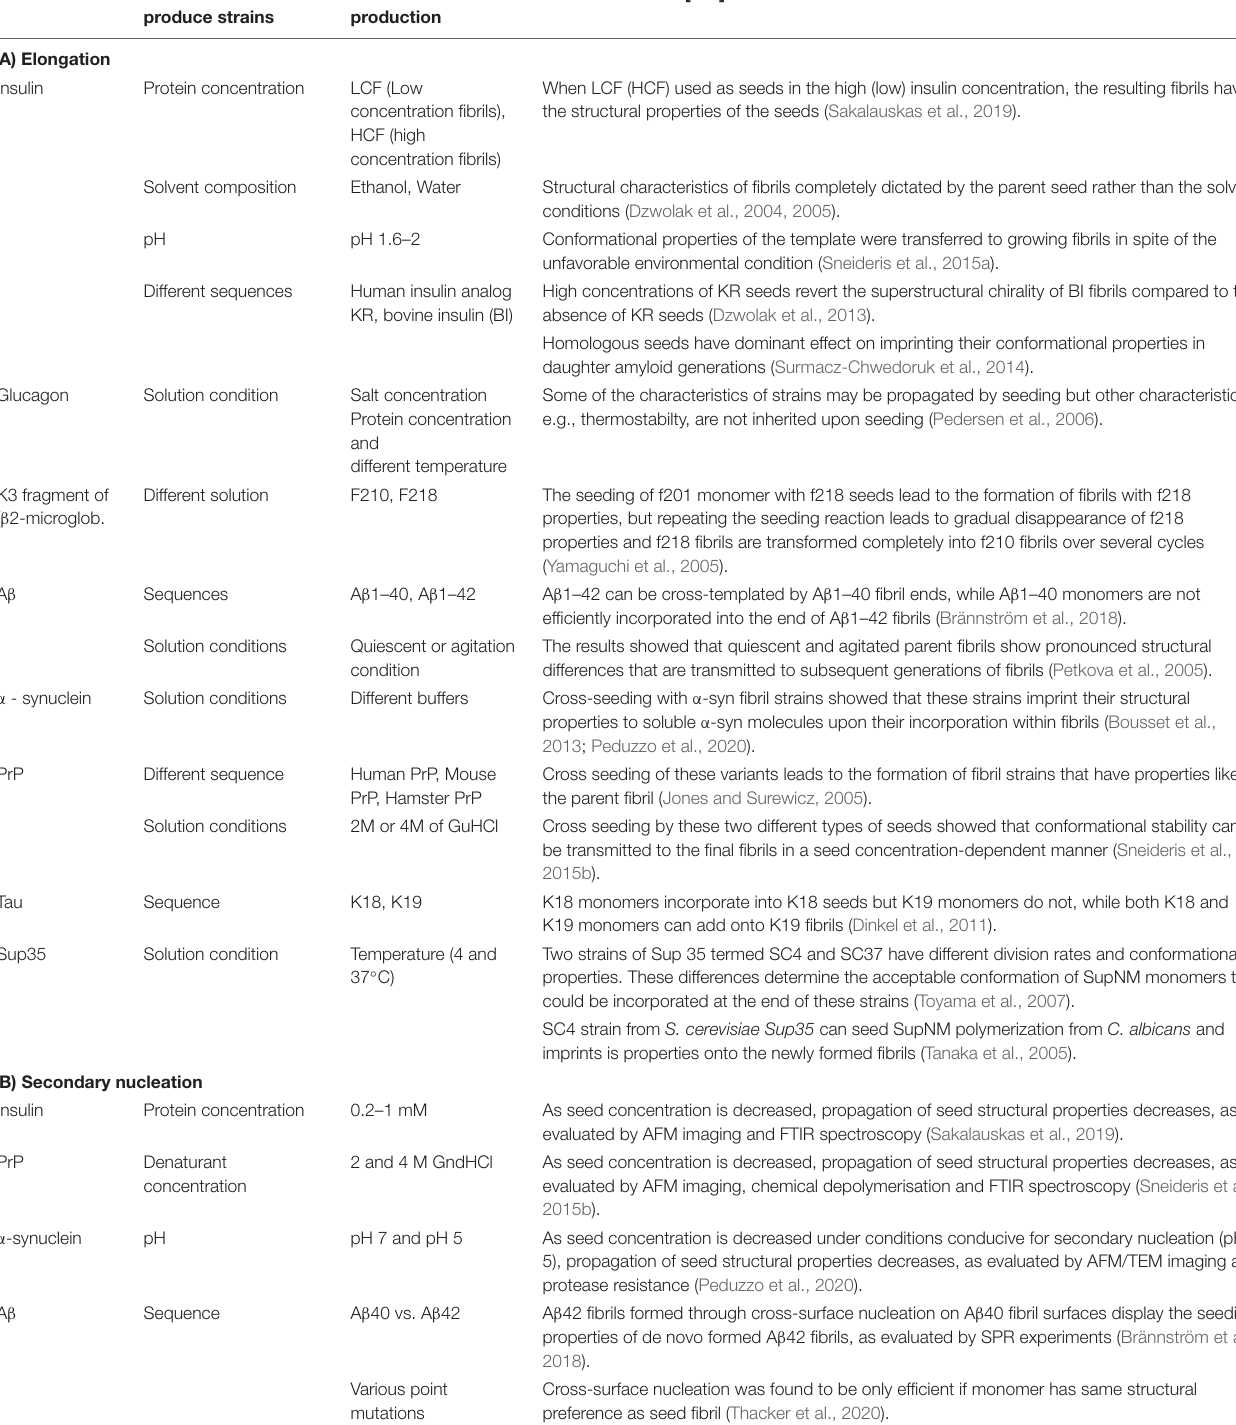
TABLE 1 | Overview over in vitro studies investigating the propagation of structural properties through (A) fibril elongation and (B) secondary nucleation. Protein Condition varied to Conditions of seed produce strains